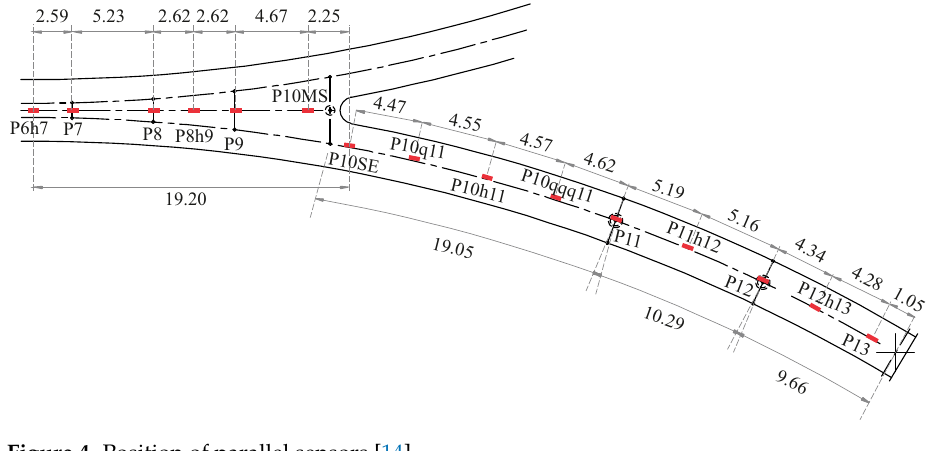
Figure 4. Position of parallel sensors